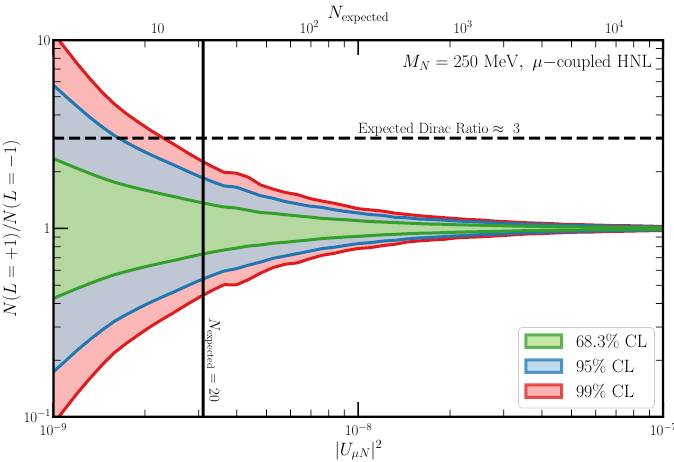
Figure 29 . Expected ability to measure the ratio of HNL decays with lepton number +1 to those with lepton number 1 assuming perfect lepton-number-identi(cid:12)cation, as a function of the (cid:0) 2 for a M mixing U (cid:22)N N = 250 MeV muon-coupled HNL. Here, we simulate data assuming N is a j j Majorana fermion; if it were a Dirac fermion, the preferred ratio would be approximately 3. Below 2 U (cid:22)N 10 (cid:0) 9 , fewer than one or two events are expected, and this procedure should not be used. j j (cid:25) The vertical line indicates where the number of signal events is 20. We have included only (cid:12)ve years of data collection in neutrino